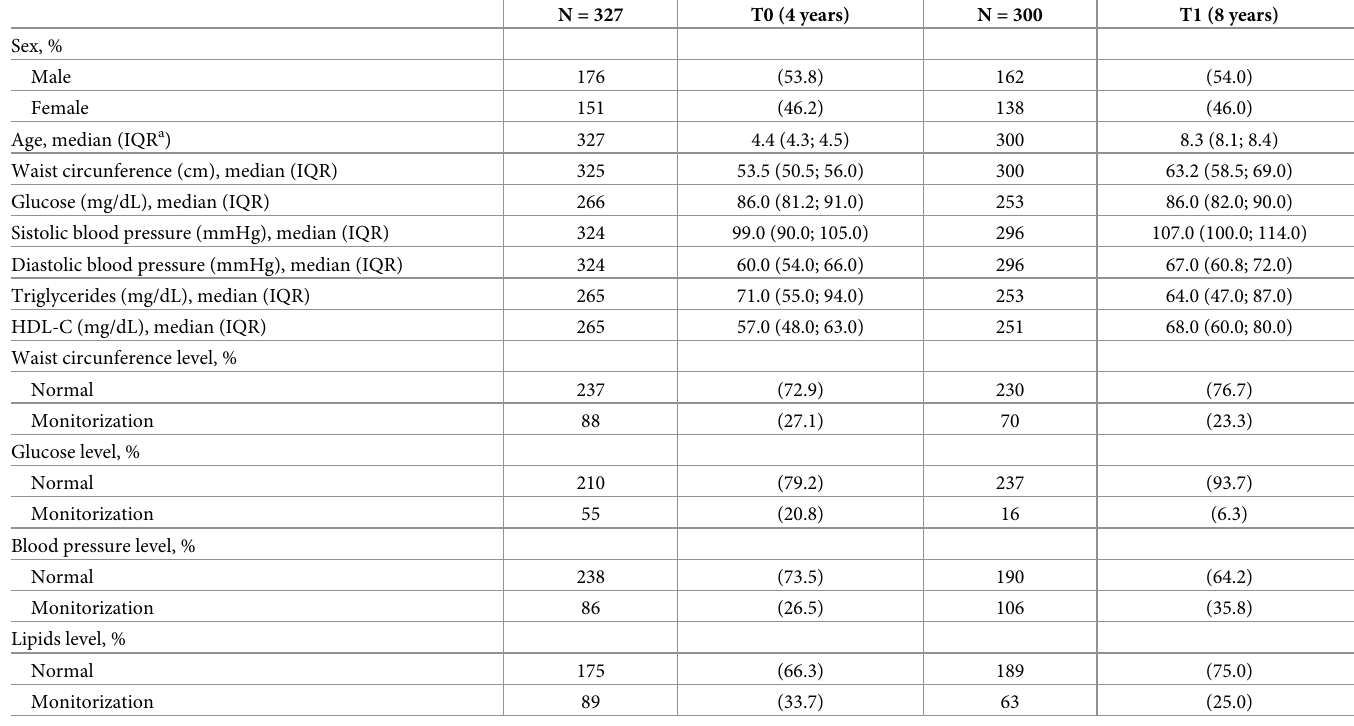
Table 1. Descriptive statistics of sex, age and cardiometabolic parameters at 4 and 8 years of age.